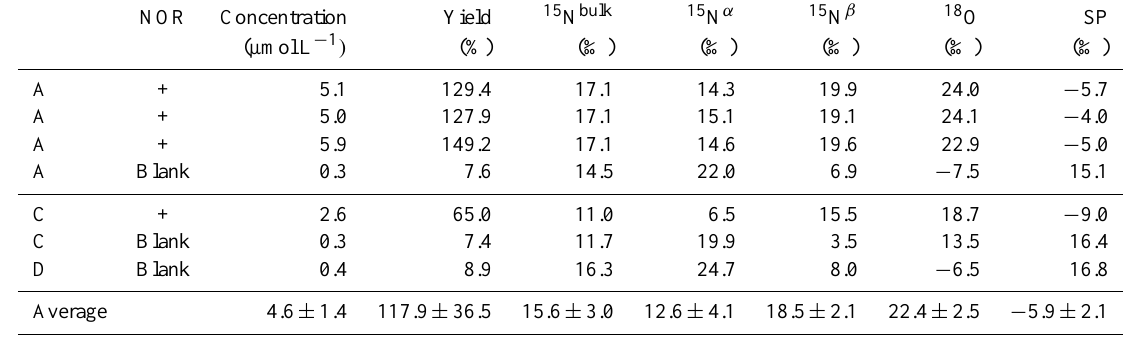
Table 3. Concentration and isotopomer ratios of N 2 O during NO reduction by NOR extracted from Paracoccus denitrificans . NOR